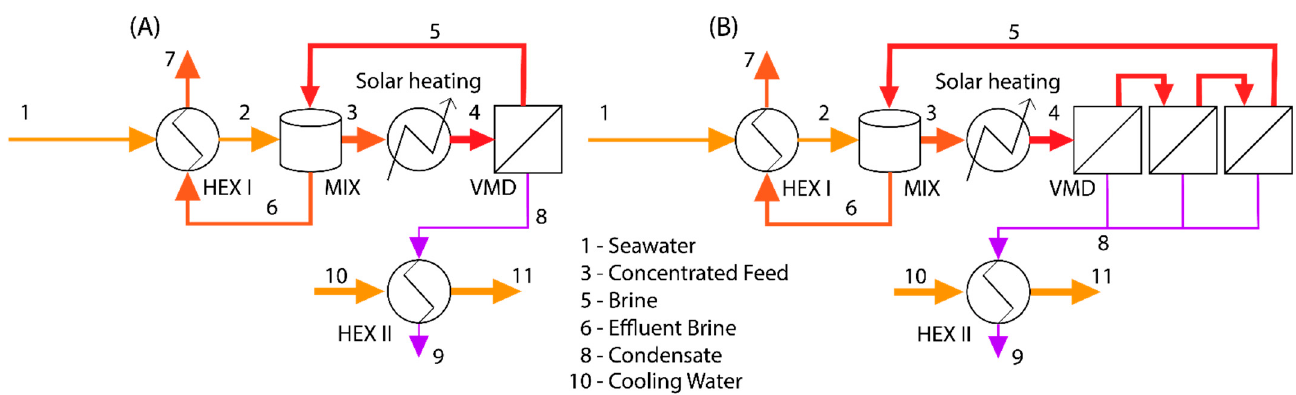
Figure 1. The solar thermal desalination scheme used for exergy analysis. Here, HEX I and HEX II refer to the heat exchanger on the feed and permeate stream, respectively. The MIX refers to a mixing tank used for thermal and concentration management of the solar-VMD loop. ( A ) A single-stage process. ( B ) A multi-stage process with 3 stages.